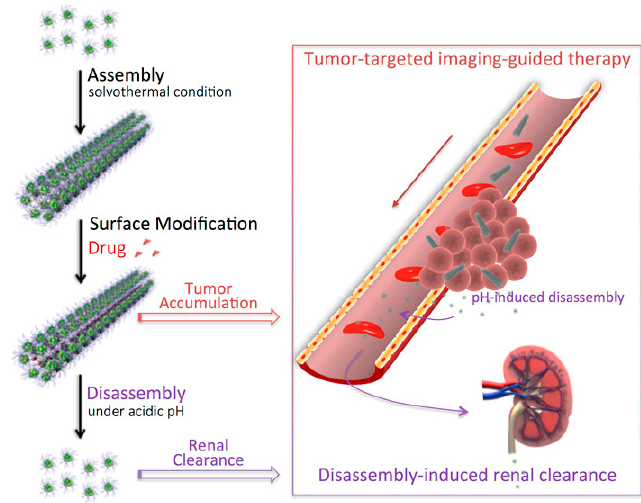
Figure 8. Production and biological pathway of bismuth subcarbonates rods as reported by [101]. Copyright 2018 American Chemical Society.